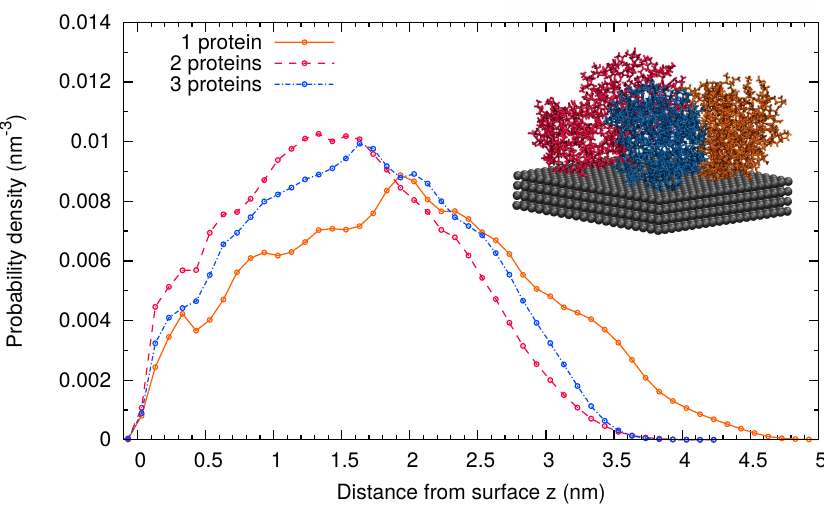
Figure 2. Probability distribution of protein atoms as a function of the distance from the adsorbing surface obtained in MD simulations with one, two or three β -casein adsorbed onto a 45.5 nm 2 hydrophobic surface and neutral pH. Inset: snapshot of the film formed by three β -casein with each protein shown in a different colors.